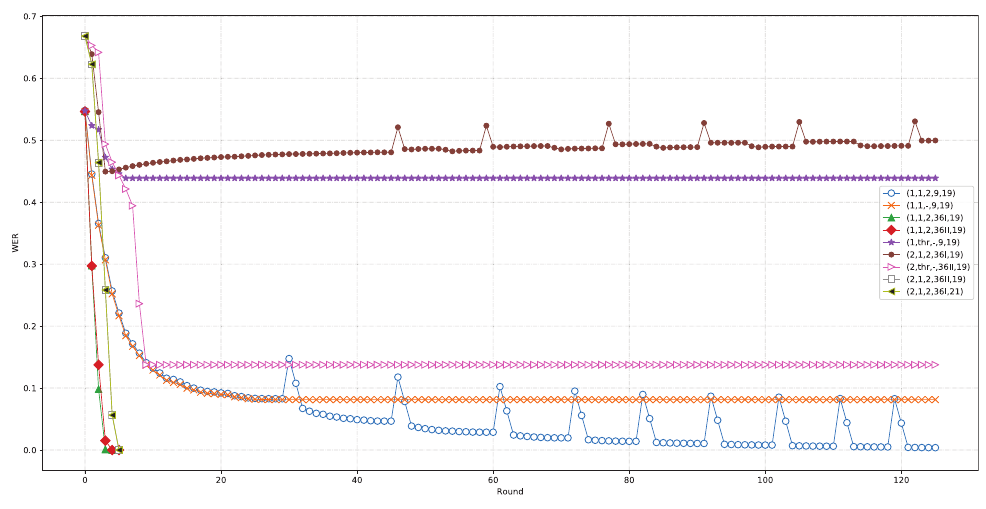
Figure 2: Several vectorial iterative decoding curves of scaled